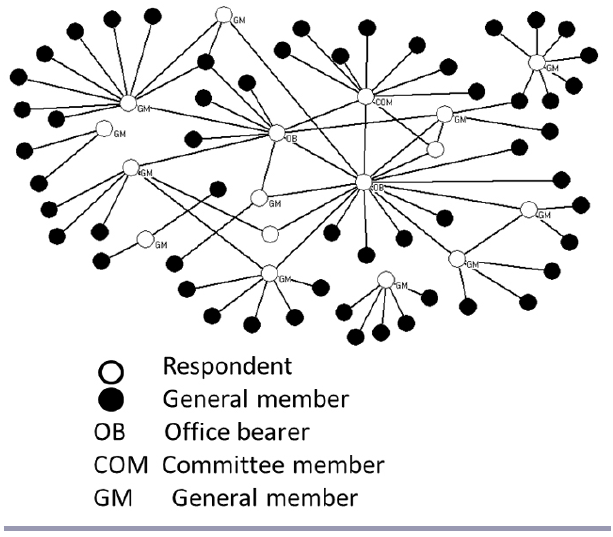
Fig. 3 . Landcare Group A issue-based social network and respondent’s role in Landcare.